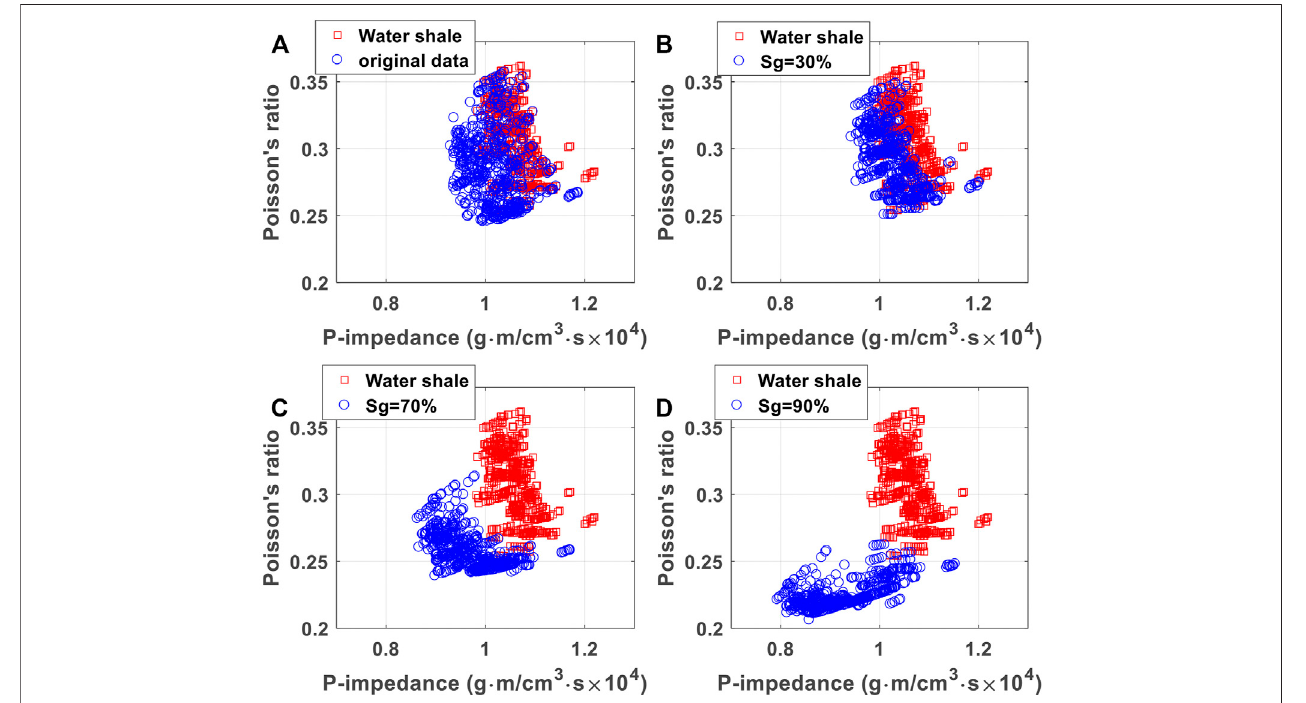
FIGURE6| FluidsubstitutionresultsoftheWufeng-Longmaxi Formationinwell-Y1.Theredsquaresrepresenttheformationwith100%watersaturation.Theblue circles represent the original well-log data in (A) and formations with gas saturations of 30, 70, and 90% in (B – D) , respectively.